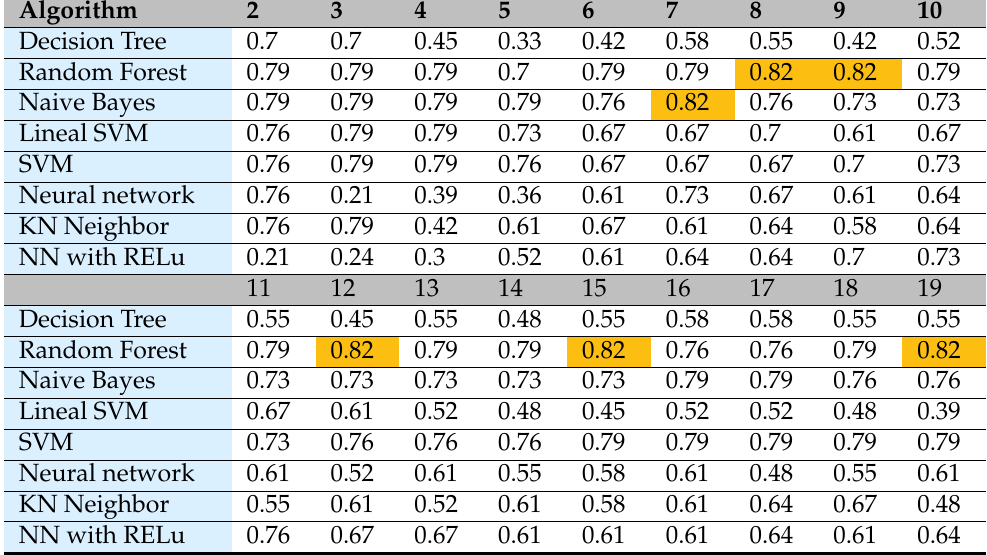
Table 1. Table of accuracy with